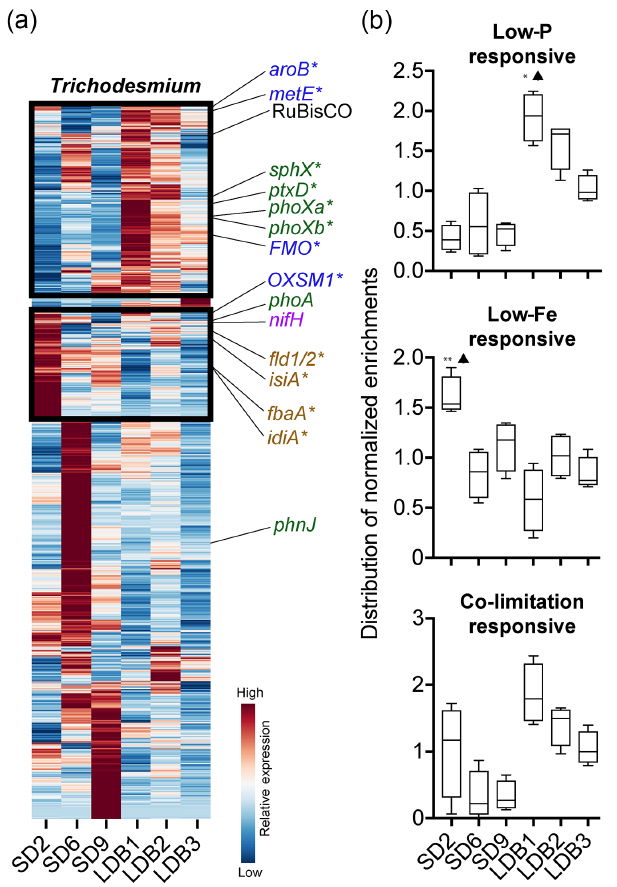
Figure 4. Trichodesmium orthologous group (OG) expression patterns. (a) Hierarchically clustered expression patterns of Tri- chodesmium OGs with key genes called out. ∗ indicates OGs used in subsequent Kolmogorov–Smirnov tests. Coloured text indicates phosphorus (green), iron (brown), co-limitation (blue), nitrogen (purple), or carbon-fixation-related (black) OGs. (b) Distribution of expression patterns in OG sets known to be significantly respon- sive in Trichodesmium to low-phosphorus (P), low-iron (Fe), and P / Fe co-limiting conditions. Distributions for each set at each sta- tion were compared to the average distribution across all six sta- tions using Kolmogorov–Smirnov tests to examine the null hypoth- esis that the expression of gene sets at a given station did not devi- ate significantly from the average expression of that set across the transect. Whiskers show the normalized enrichment level for the least and most enriched OG in that set. Boxes denote the upper and lower 25th percentiles, while the line indicates the median enrich- ment expression value. Asterisks indicate significance: ∗ p <0.05, ∗∗ p <0.005. Black triangles denote whether significant stations were increased or decreased relative to the mean.